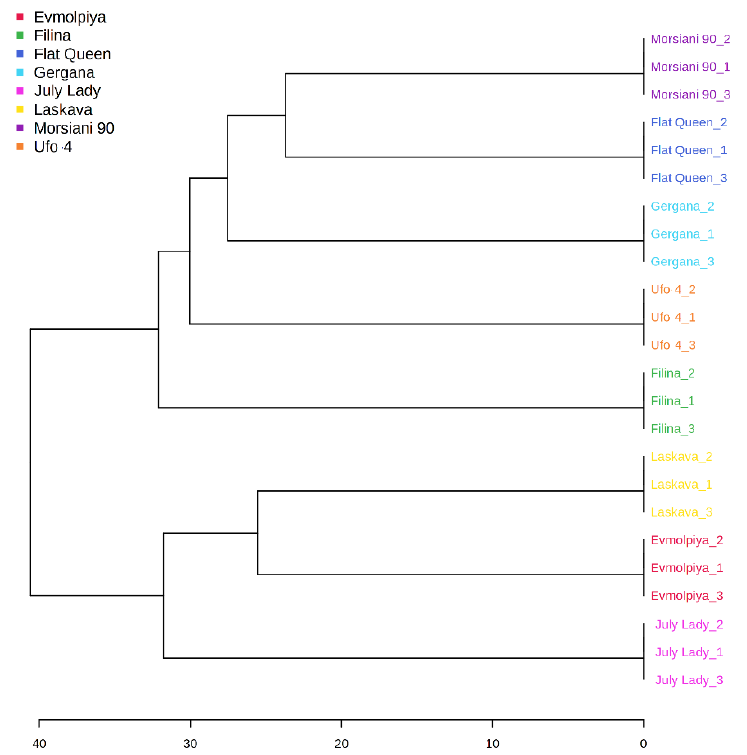
Figure 3. Clustering result of peach varieties, shown as a dendrogram (by Euclidean distance measure and Ward’s clustering algorithm).